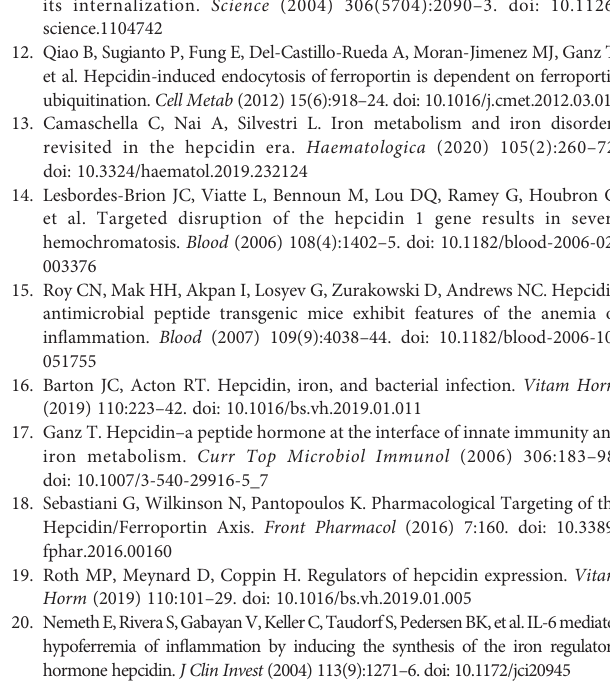
Supplementary Figure 1 | Box plots comparing hepcidin expression in normal individuals and lung cancer patients obtained from the Oncomine database. Supplementary Figure 2 | Box plots evaluating hepcidin expression among different groups of patients based on clinical parameters using the UALCAN database. Analysis is shown for TP53 mutation status (A) , age (B) , and race (C) . *p < 0.5, **p < 0.01, ***p < 0.001. Supplementary Figure 3 | Alteration frequency of hepcidin. (A) Summary of alterations in hepcidin. (B) OncoPrint visual summary of alterations in a query of hepcidin from cBioPortal. (C) Kaplan-Meier plots comparing OS and PFS in cases with or without hepcidin gene alterations. Supplementary Figure 4 | GO analysis for hepcidin. (A) A heat map showing the top 50 genes negatively correlated with hepcidin in LUAD. (B) A heat map showing the top 50 genes negatively correlated with hepcidin in LUSC. (C) Top 20 enrichment terms in MF categories in LUAD. (D) Top 20 enrichment terms in MF categoriesinLUSC. (E) Top20enrichmenttermsinCCcategoriesinLUAD. (F) Top 20 enrichment terms in CC categories in LUSC. Supplementary Figure 5 | Enrichment plots from GSEA. (A, B) A merged plot showing the pathways associated with hepcidin expression in LUAD and LUSC based on GO analyses. (C, D) A merged plot showing the pathways associated with hepcidin expression in LUAD and LUSC based on KEGG analyses. Supplementary Figure 6 | Scatterplots of correlations between hepcidin expression and in fi ltration levels of immune cells in LUAD. Supplementary Figure 7 | Scatterplots of correlations between hepcidin expression and in fi ltration levels of immune cells in